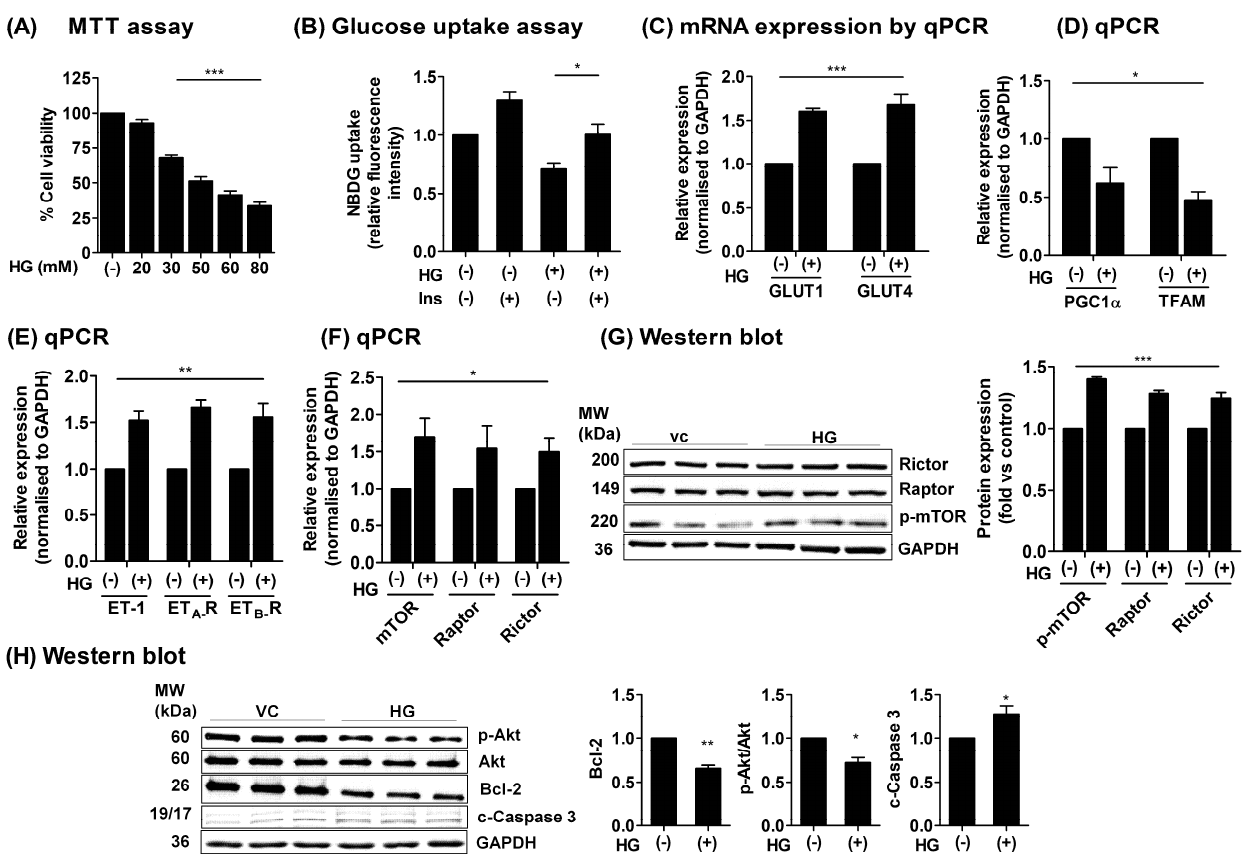
Figure 1. Effect of high glucose (HG) treatment in H9c2 cells. ( A ) The H9c2 cells were seeded in low glucose DMEM medium (5.5 mM) and treated with various concentrations of D-glucose-containing medium (vc = vehicle control, 20 mM, 30 mM, 50 mM, 60 mM, and 80 mM) for 24 h. Cell viability was assessed by MTT assay. ( B ) The H9c2 cells were seeded in low glucose DMEM medium overnight and incubated with HG medium for 24 h and subjected to 2-NBDG-based glucose uptake assay. The fluorescent intensity was measured at wavelengths λ ex/ λ em: 485/530 nm. ( C – F ) The H9c2 cells were treated with HG for 24 h, and total RNA was extracted. The mRNA expression level of GLUT1, GLUT4, ET-1, ET A -R, ET B -R, mTOR, Raptor, Rictor, PGC1 α , and TFAM genes were determined by qPCR and normalized to GAPDH and expressed as fold versus non-treated controls (vc) (2 − ∆∆ CT ). ( G , H ) The H9c2 cells were treated with HG as above, and proteins were extracted after 24 h of incubation. Protein expressions of p-mTOR/Raptor/Rictor ( G ) and survival markers p-Akt, Akt, Bcl-2, and c-Caspase-3 ( H ) were determined using western blotting. N = 3; Mean ± S.E.M.; * p < 0.05, ** p < 0.01, *** p < 0.001.